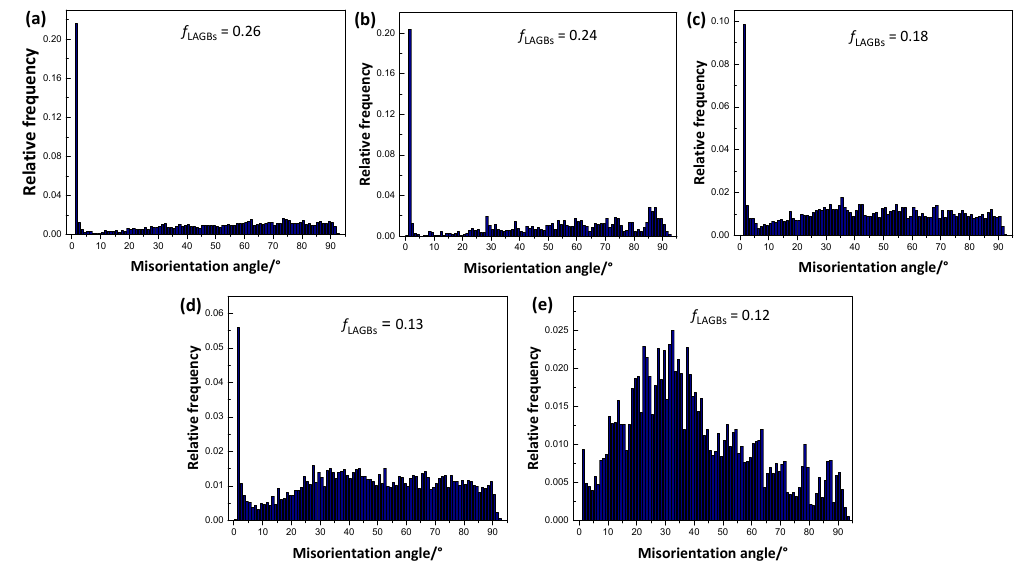
Figure 10. Distribution of grain boundaries misorientation of as-extruded alloys: ( a ) Alloy1, ( b ) Alloy2, ( c ) Alloy3, ( d ) Alloy4 and ( e ) Alloy5.